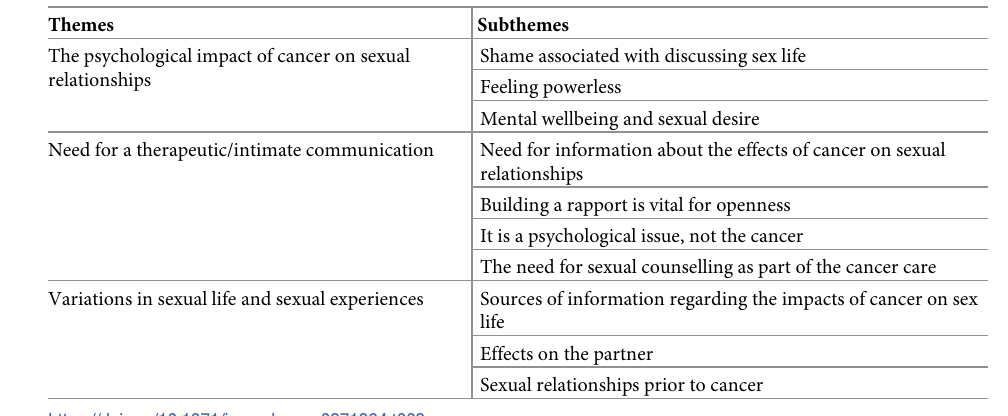
Table 2. Summary of the